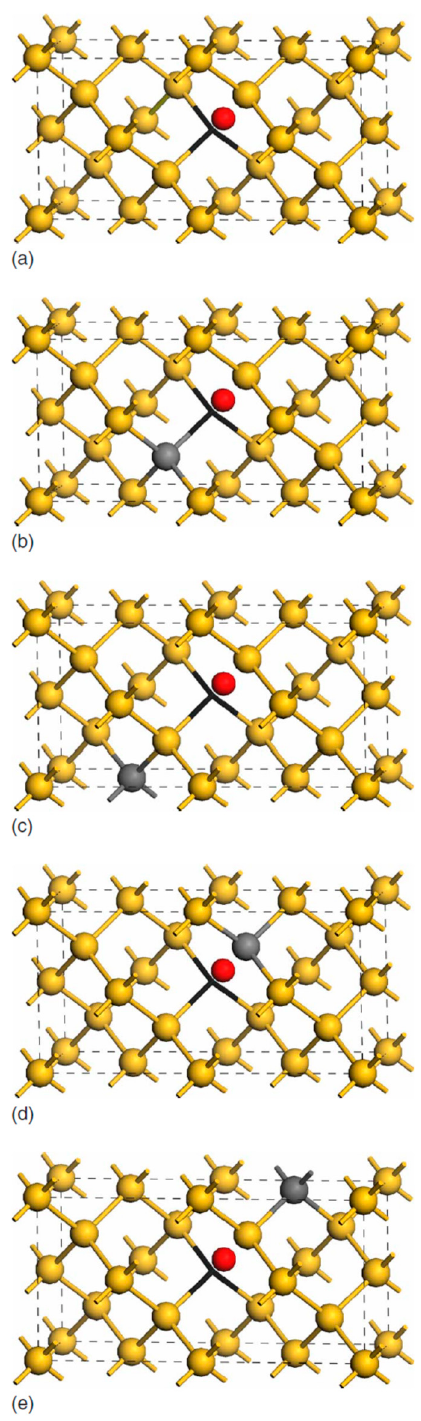
Figure 13. An illustration of the minimum energy structure of ( a ) the VO (A-center), ( b ) the nearest neighbor D VO, ( c ) the next nearest neighbor D VO, ( d ) the nearest neighbor D OV, and ( e ) the next nearest neighbor D OV defects. Yellow and gray spheres indicate the Si and D atoms, respectively, whereas O i are represented by the red spheres, and the vacant site by the black sticks. Reprinted with permission from [148]. American Institute of Physics, 2010.